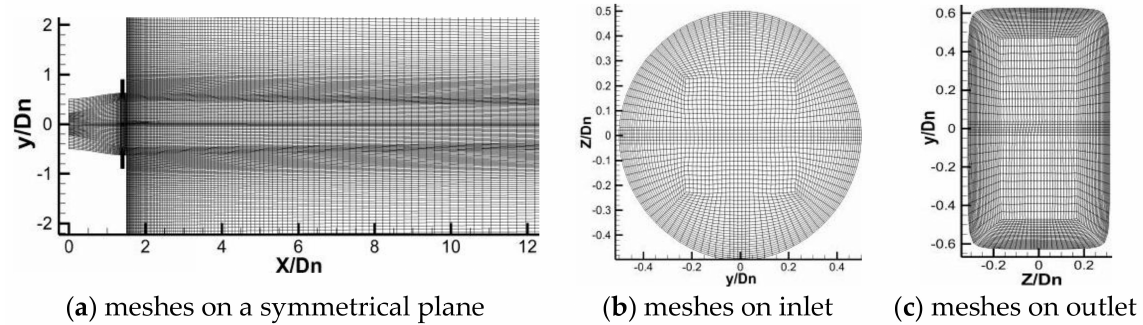
Figure 3. Meshes for flow